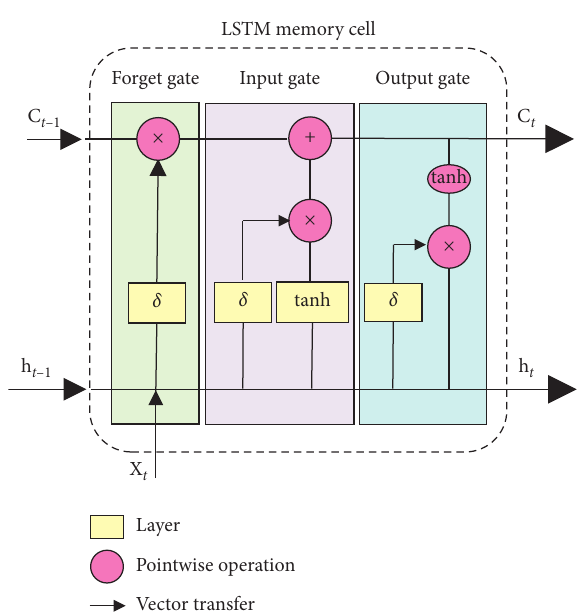
Figure 3: Structure of a standard LSTM